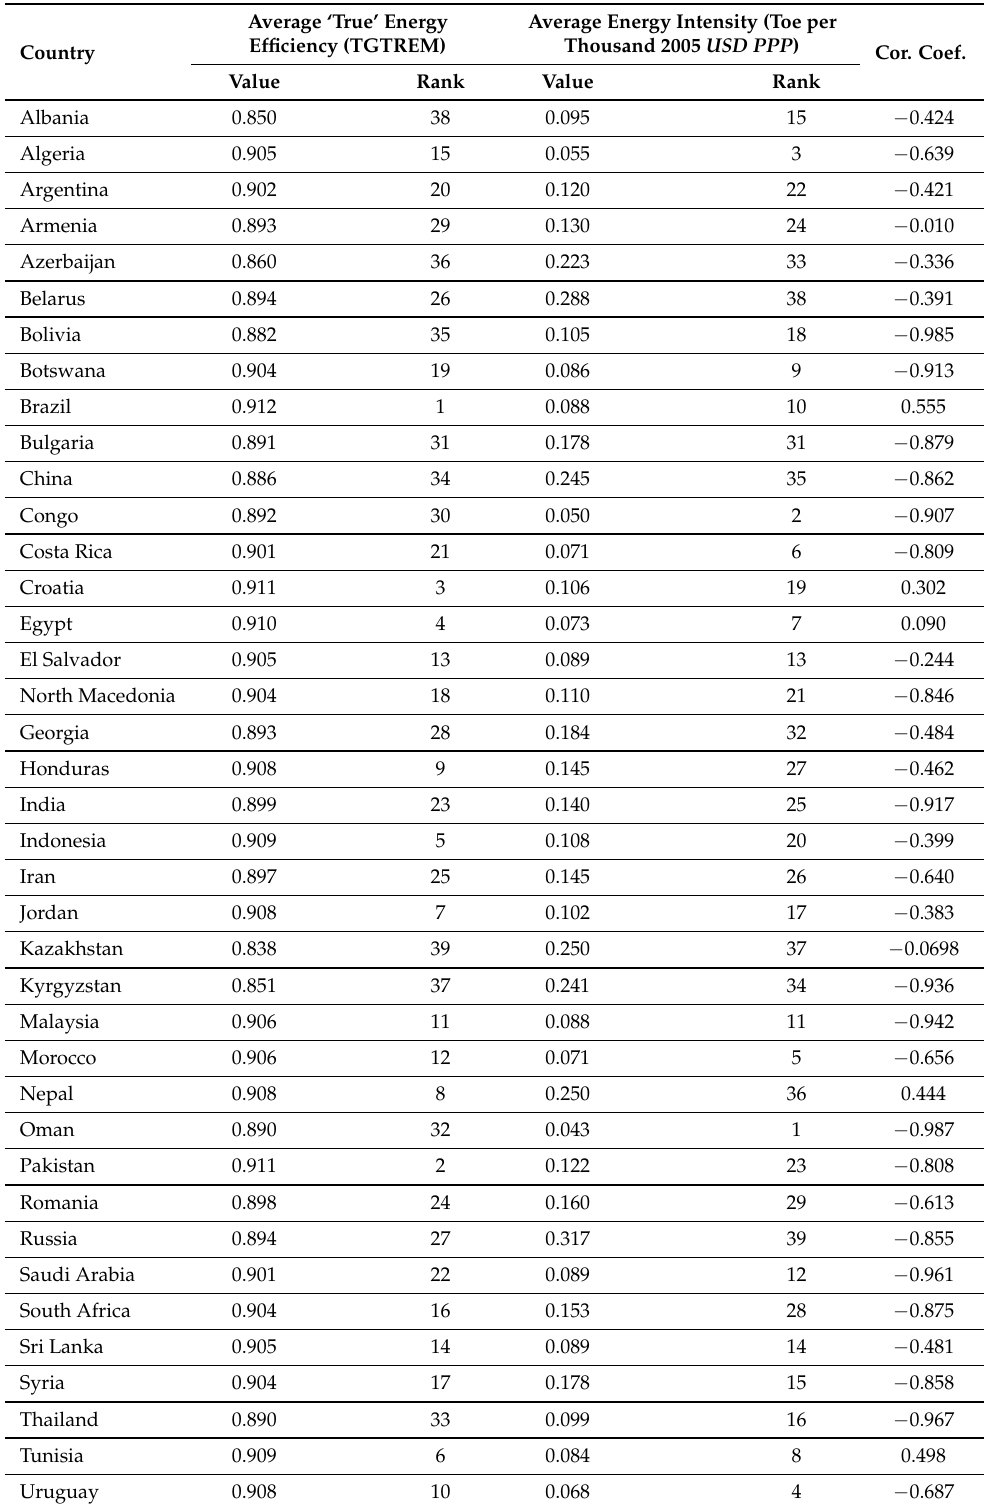
Table 8. Each country’s average energy efficiency and energy intensity for the period 1989–2008, their rankings, and the correlation coefficients between